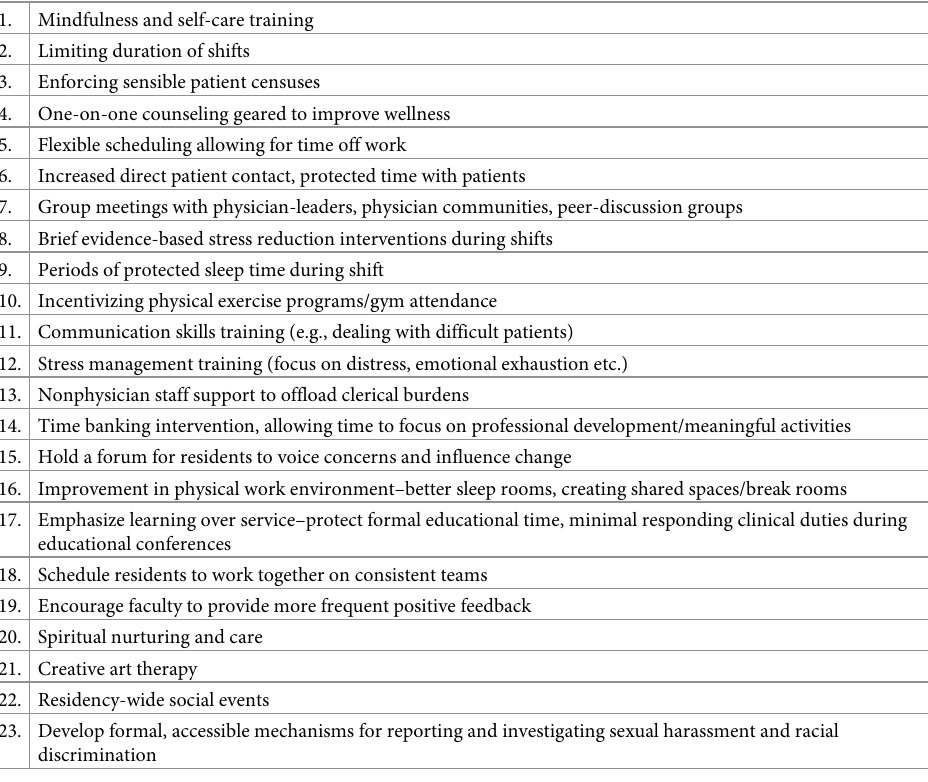
Table 2. List of potentially important